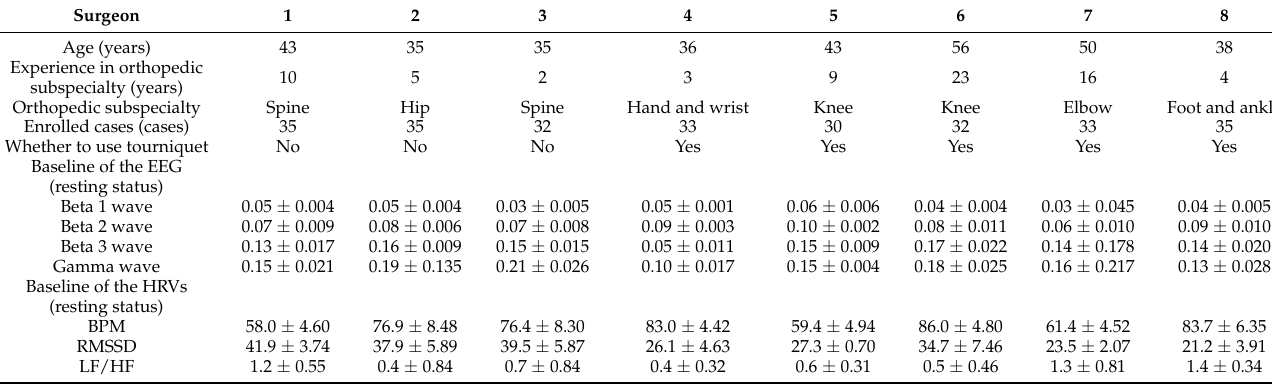
Table 1. Demographic Characteristics of the Enrolled Surgeons. Baseline of the EEG is presented as ratio per whole frequency EEG. Beta 1: low beta waves, 12–15 Hz; Beta 2: mid-range beta waves, 15–20 Hz; Beta 3: high beta waves, 20–30 Hz; Gamma; 30–50 Hz; BPM: beats per minute, RMSSD: square root of the mean R-R interval; LF: low frequency, HF: high frequency. Baseline of the EEG was presented as ratio per whole EEG frequency. Values were presented as mean ± standard